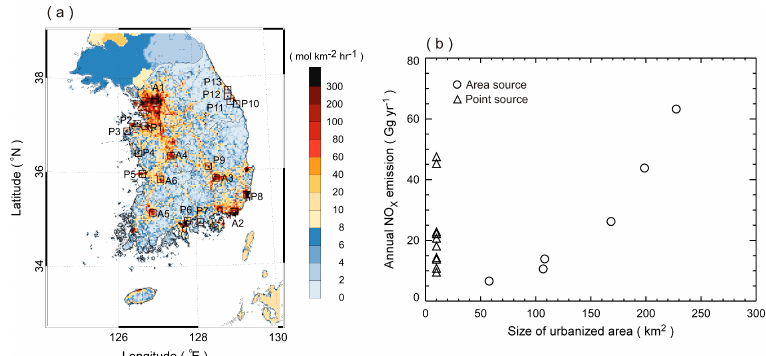
Figure 3. ( a ) The spatial distribution of anthropogenic NO X emissions used for the simulations of the WRF-Chem and WRF / CMAQ models. A and P denote the highly urbanized area sources and the isolated point sources in South Korea, respectively. ( b ) A comparison of the annual NO X emissions of the selected area and point sources with their urbanized area. The source area of the point emissions is fixed by 3 × 3 km 2 for